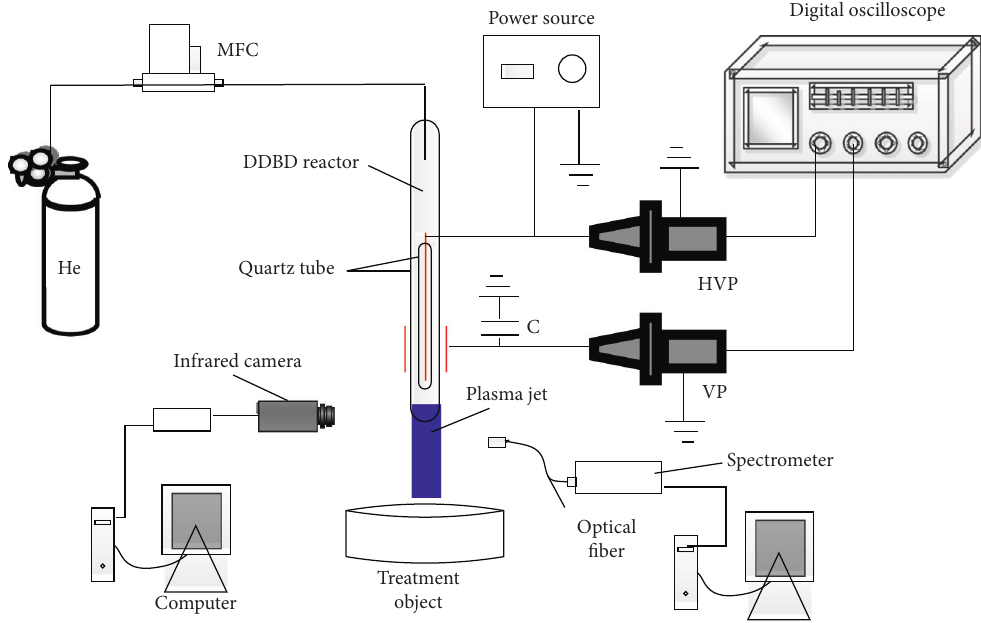
Figure 1: Schematic diagram of experimental